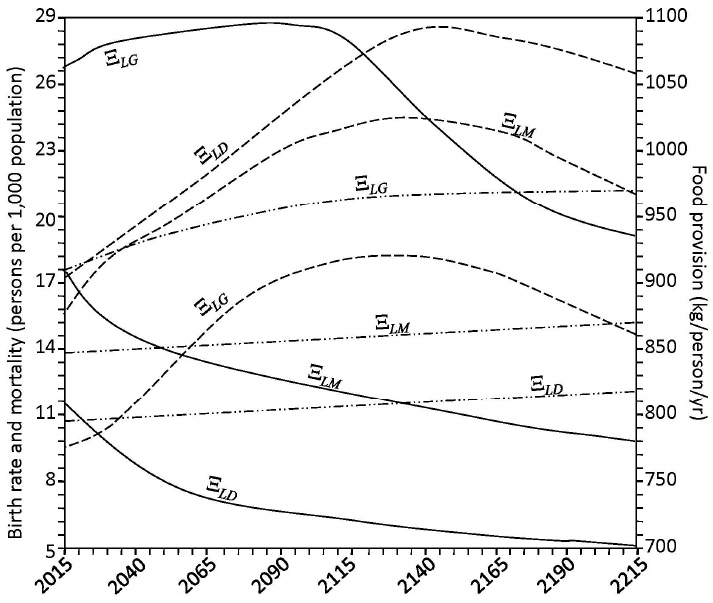
Figure 12. The dynamics of the vital factors (supply of food by region, birth rate, and mortality are represented by the broken, solid, and chain lines, respectively). Regional identifiers are placed on the curves.